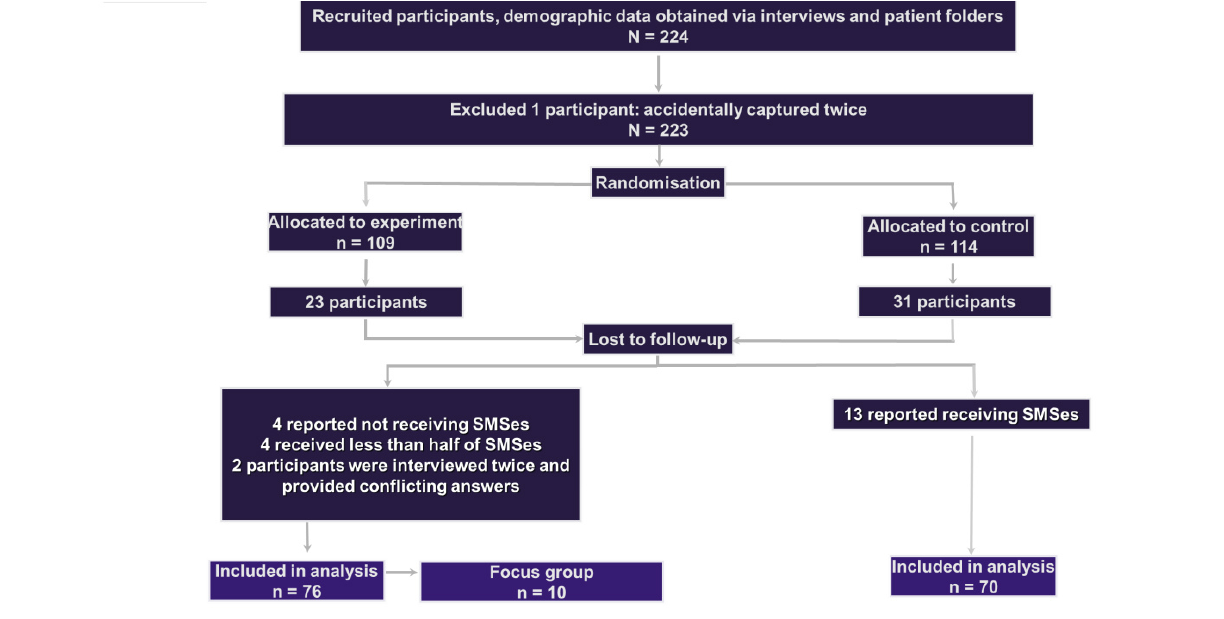
Figure 1. Participant diagram. 224 participants were originally recruited, but due to loss to follow up and various exclusion criteria, only 146 (76 in experimental arm, 70 in control arm) were included in the final